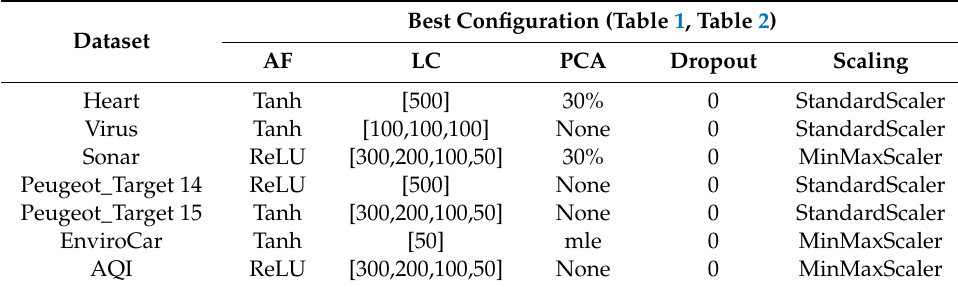
Table 7. ANN corresponding configurations. Best Configuration (Table 1, Table